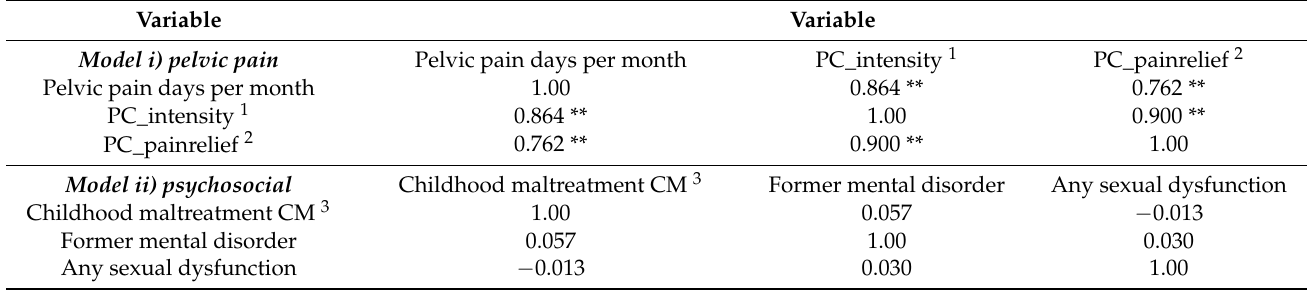
Table A1. Nonparametric bivariate correlation analyses between the independent predictor variables in the models i) pelvic pain and ii) psychosocial.